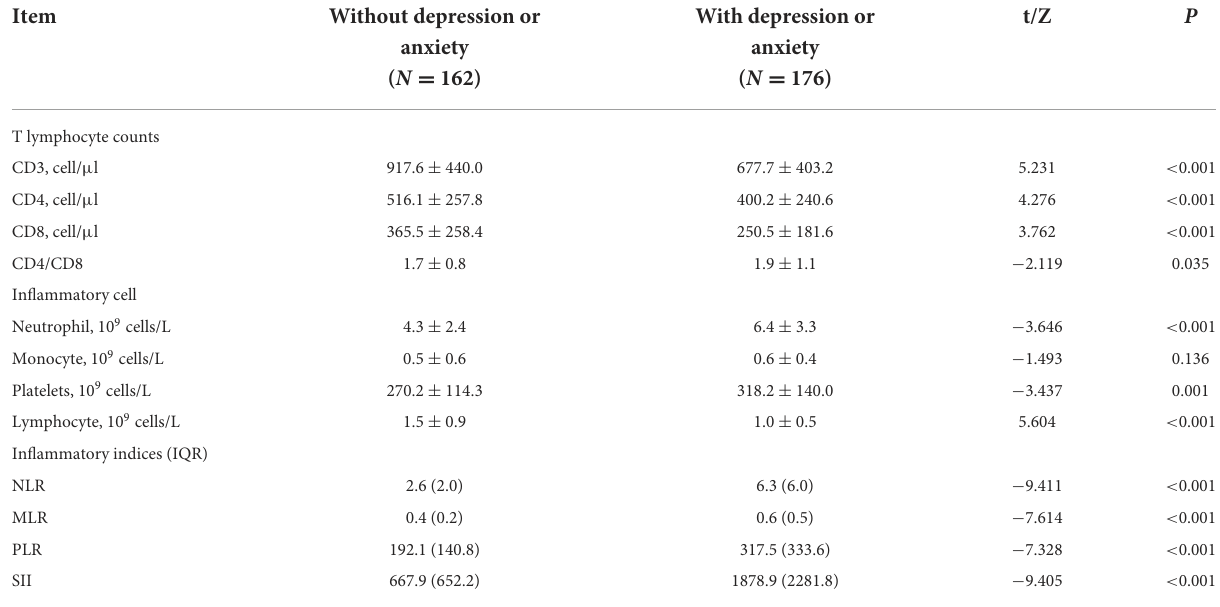
TABLE 2 Immune-inflammatory parameters in patients with